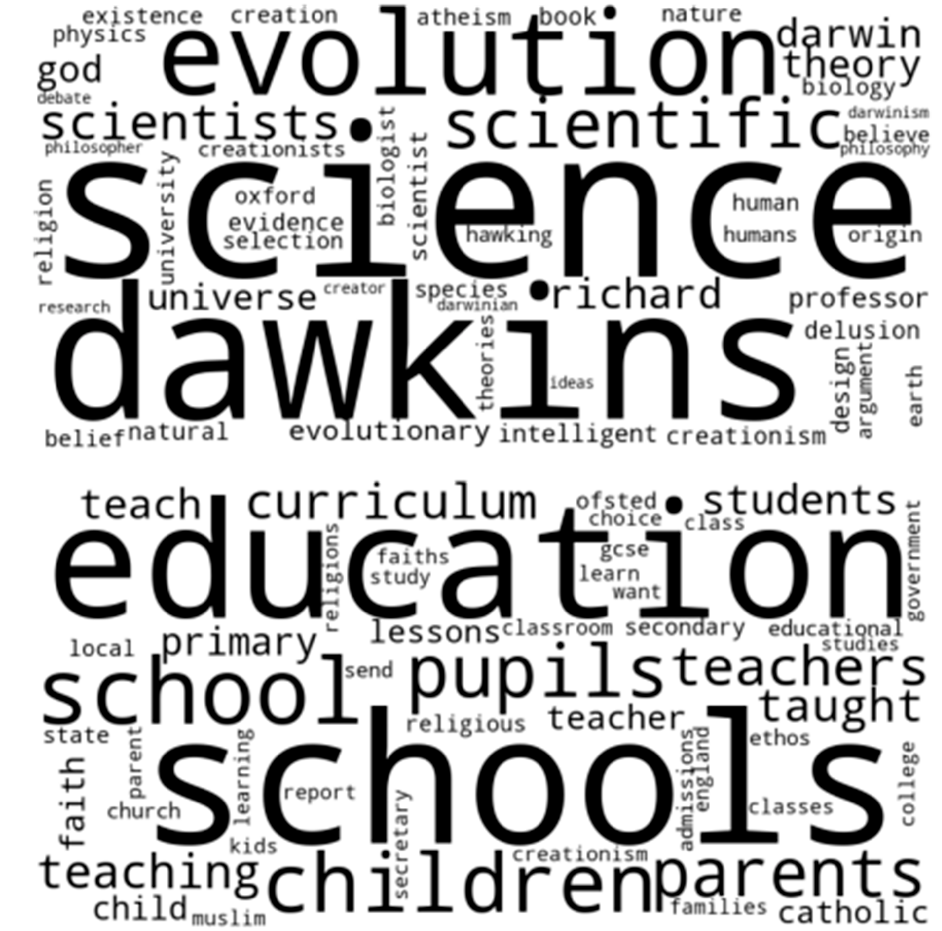
Figure 3. Word clouds for the “science” and “education” topics.